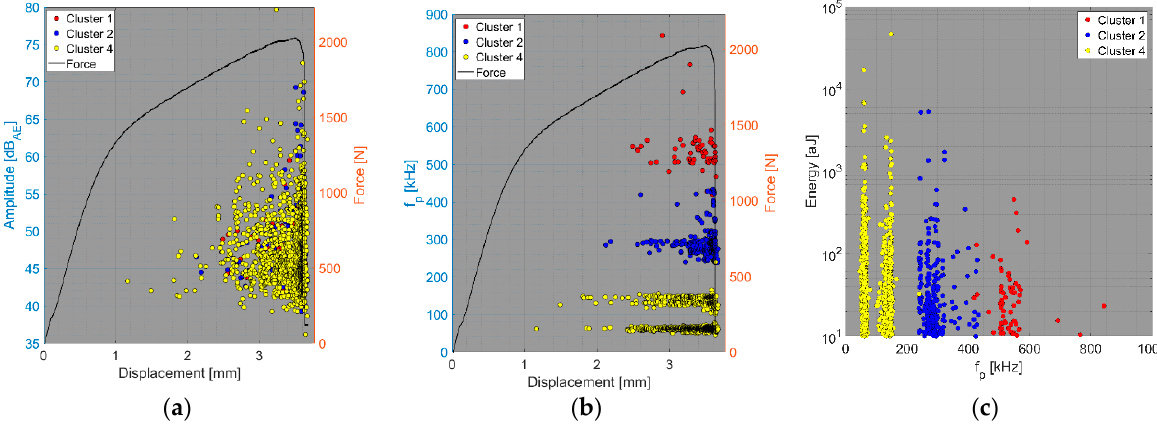
Figure 23. Clustering results for a CPTS representative sample using a spectral clustering algorithm (DWC 454 dataset).